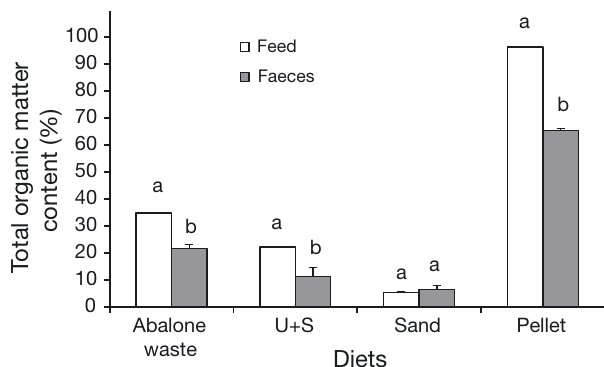
Fig. 3. Mean (+SE) total organic matter of feed and resultant faeces of Neostichopus grammatus fed 4 experimental diets (n = 4). Different letters above each bar within a diet indi- cate a significant difference between feed and faeces (t -test, p < 0.05). U+S: Ulva lacinulata mixed with (p = 0.019) and sand (p = 0.002). The faecal TOM of